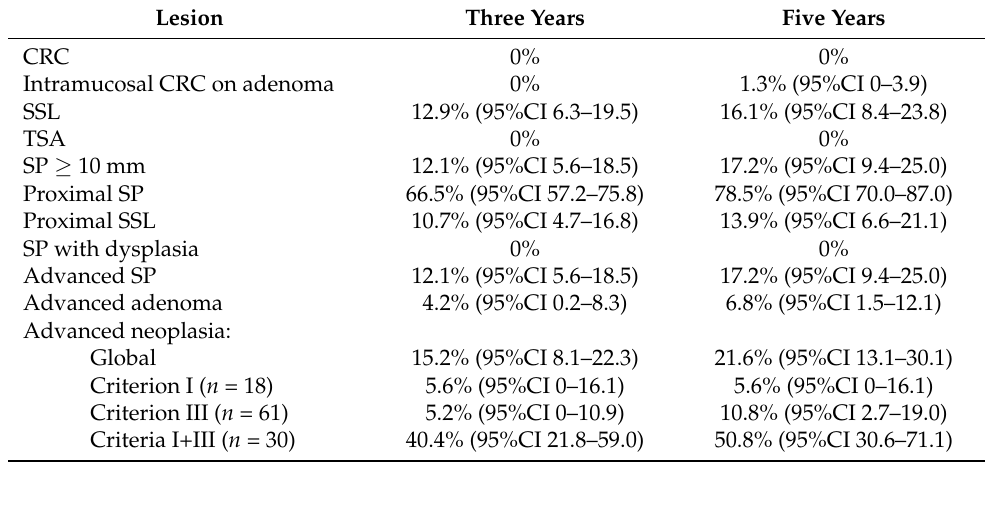
Table 4. Cumulative incidence of lesions during follow-up.